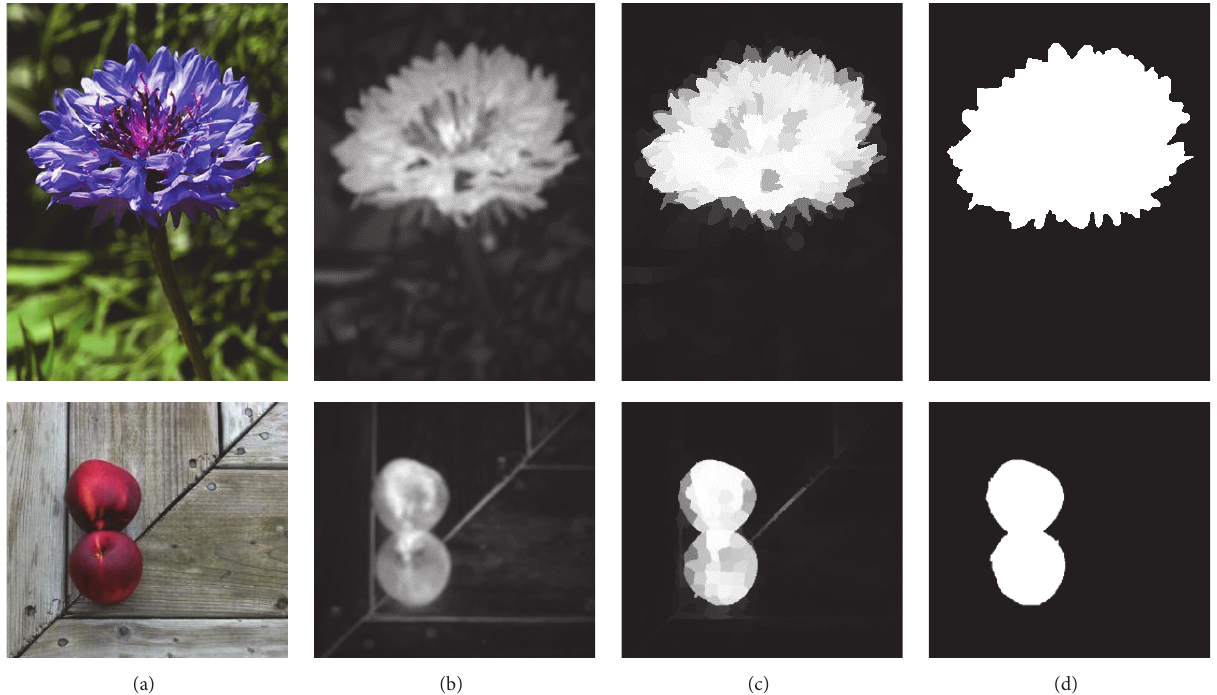
Figure 3: Edge-preserving element-level filtering. (a) Input image. (b) Coarse saliency map. (c) Saliency map after edge-preserving element- level filtering. (d) Ground